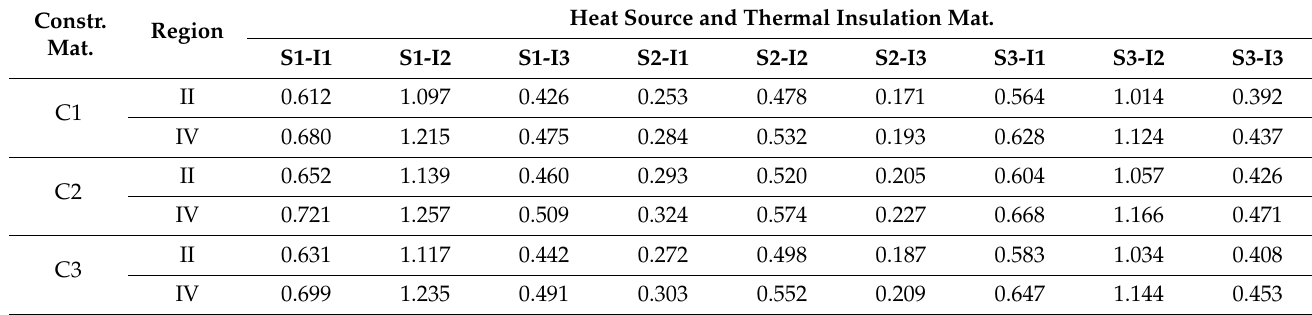
Table 8. Thermal insulation optimum thicknesses for ecological reasons d Eopt (m). Constr. Region Mat.